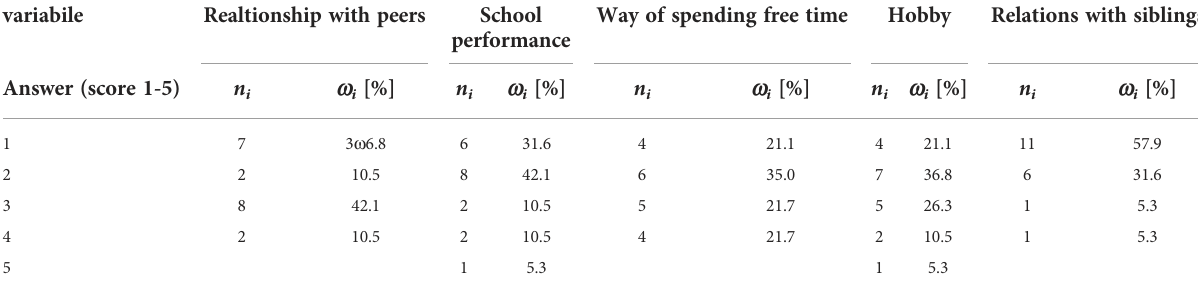
TABLE 2 The in fl uence of the disease on key aspects of adolescent ’ s lives. variabile Realtionship with peers School Way of spending free time Hobby Relations with performance